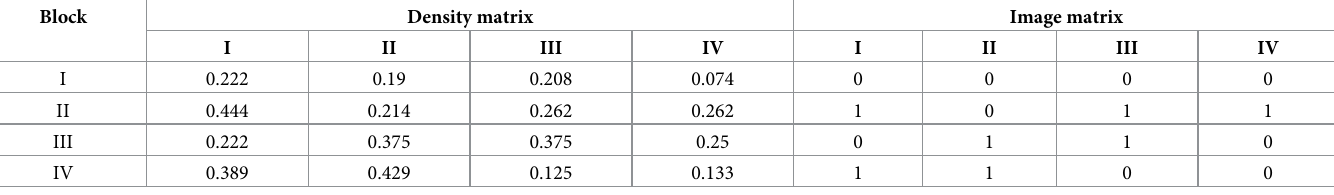
Table 4. Relationships between blocks: Spillover density matrix and image